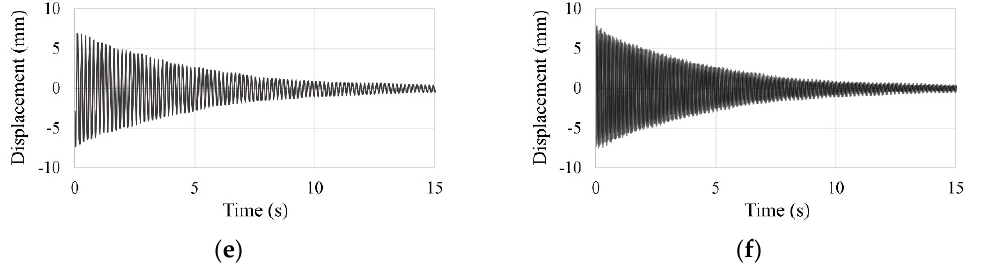
Figure 7. Time history curve of the SDOF model by free vibration test: ( a ) first test; ( b ) second test; ( c ) third test; ( d ) fourth test; ( e ) five test; ( f ) overlapping entire tests.